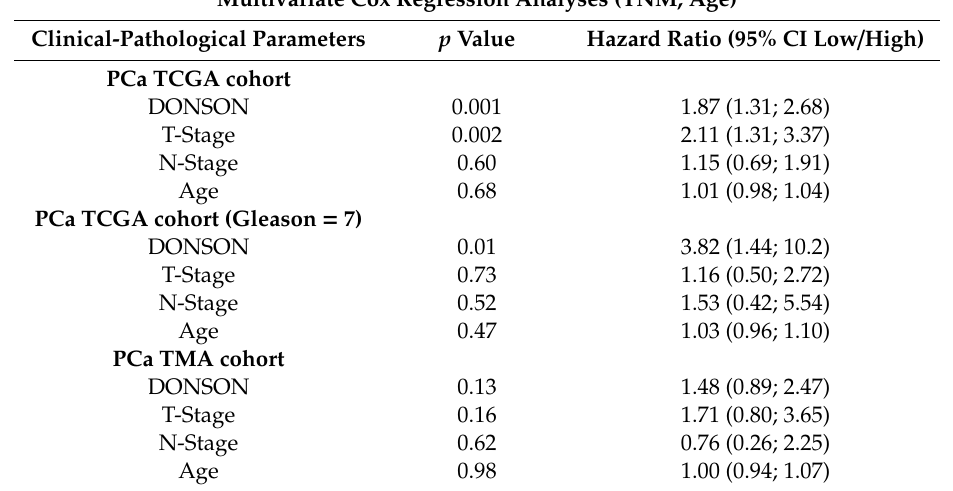
Table 1. Multivariate Cox Regression Analyses in the evaluated prostate cancer (PCa) cohorts regarding progression-free survival (PFS). Multivariate Cox Regression Analyses (TNM, Age) Clinical-Pathological Parameters p